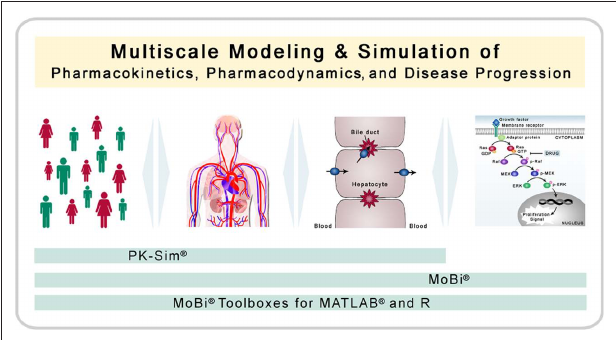
Figure 1 | Multiscale modeling and simulation. The software platform is designed for modeling and simulation of biological process with a focus on pharmacokinetics, pharmacodynamics, and disease progression (including biochemical reaction networks). Thereby, the platform allows the combination of multiple organizational and physiological scales. PK-Sim ® has a focus on whole-body physiology and its variability in populations, whereas MoBi ® has a focus on the cellular and molecular